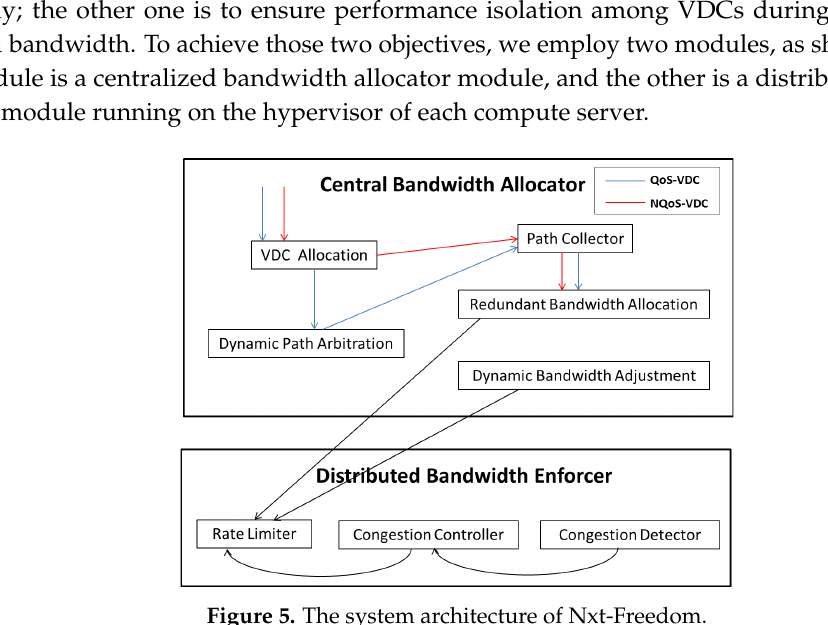
Figure 5. The system architecture of